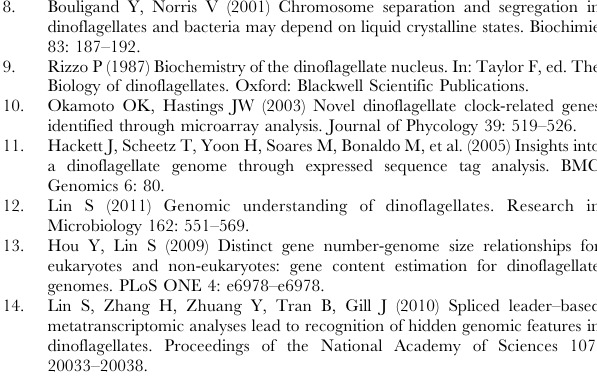
Figure S1 Relative fraction of all transcription factor domains in the Symbiodinium transcriptomes, all Dinoflagellate ESTs from the NCBI database, and other eukaryotes. Values shown were arcsine transformed. Searches were performed by using HMMER to query the Pfam models for DNA binding domains with an e-value cutoff of 1e 2 6. Table S1 Cluster numbers and contigs and singlets contained in the clusters. Table S2 Contigs and singlets of the actin gene family and their grouping into contigs (90% similarity). Table S3 Histone genes and sequences. Table S4 Distribution of contigs and singlets among KEGG categories and subcategories. Table S5 Universal single-copy clusters of orthologous groups (COGs) that were used for transcriptome completeness analysis in this study. COGs not identified in Symbiodinium transcriptomes are boldfaced. Table S6 Number of transcription factor domains found in Symbiodinium and other eukaryotes. Table S7 Transcription factor domain counts in